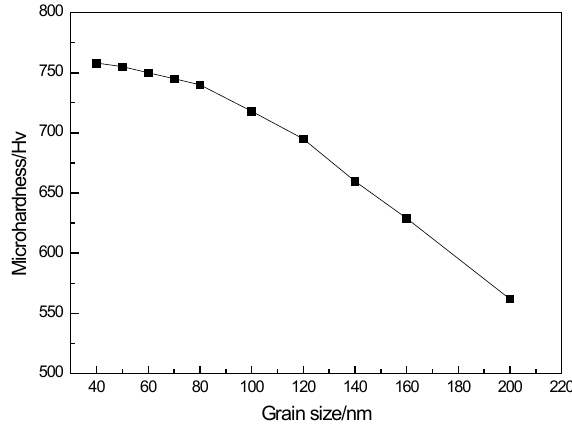
Figure 5: Influence of nanocrystalline on the microhardness of carbon fiber composite electroforming deposit.